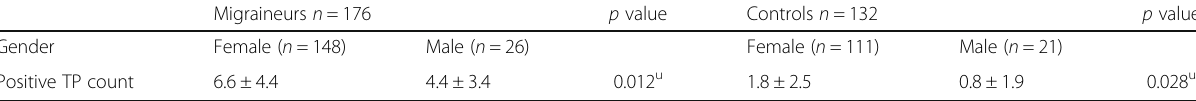
Table 2 Comparison between the positive TP count in migraineurs and those of controls separated by gender